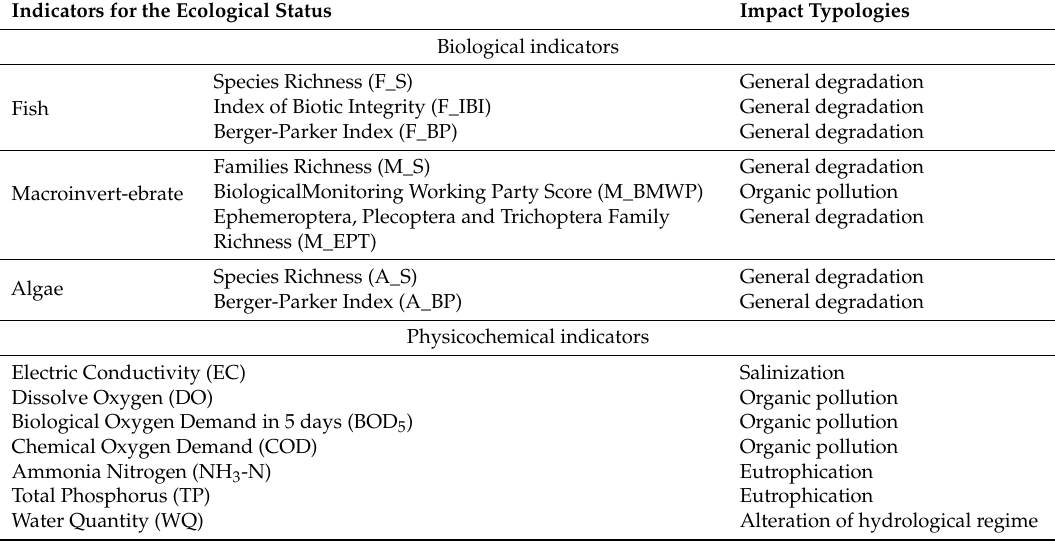
Table 1. Indicators applied in the SVM (support vector machine) model and related impact